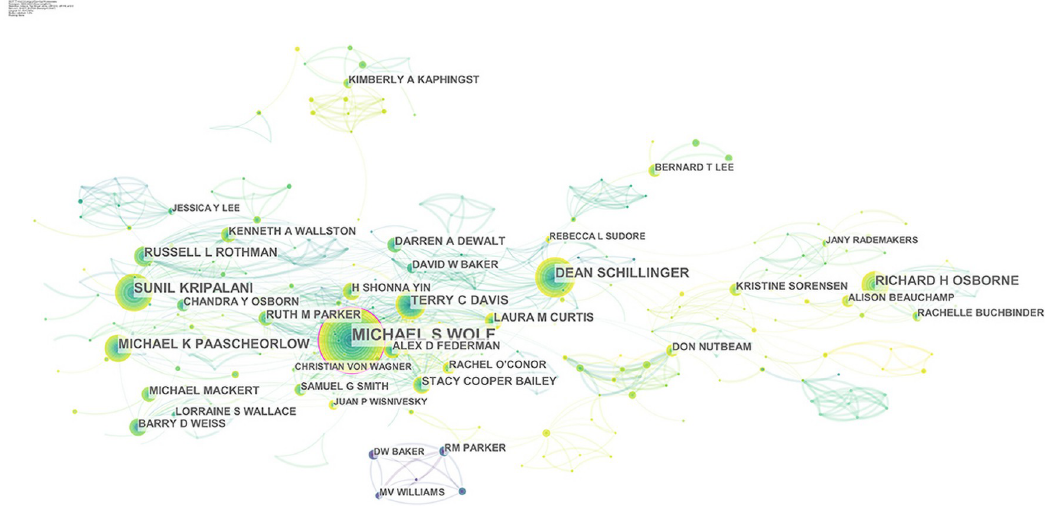
Fig 5. Author collaboration network of health literacy. Each node represents an author, and the size of the node indicates the number of publications of the author. Each edge indicates a collaborative relationship between two authors.